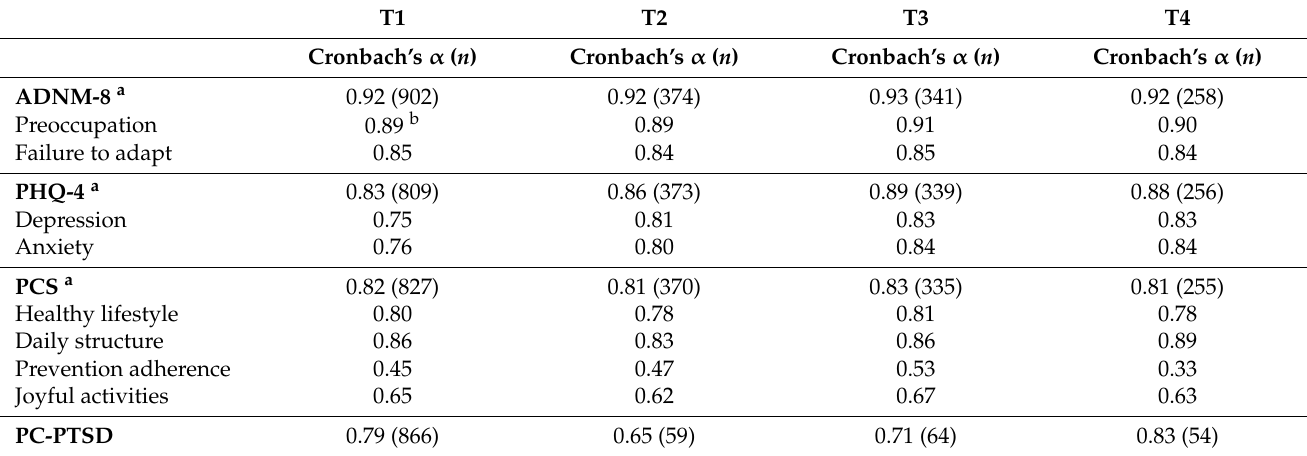
Table 2. Internal consistency of the included measures across four assessment